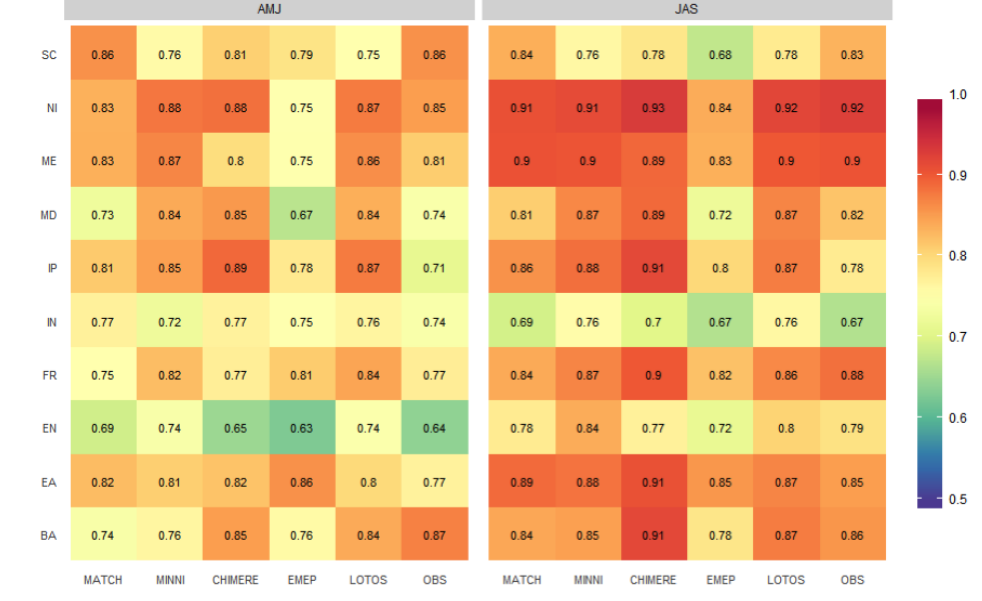
Figure 4. Coefficients of determination ( R 2 ) for each CTM-based (ordered as in Fig. 3) and observation-based MLR in spring (AMJ) and summer